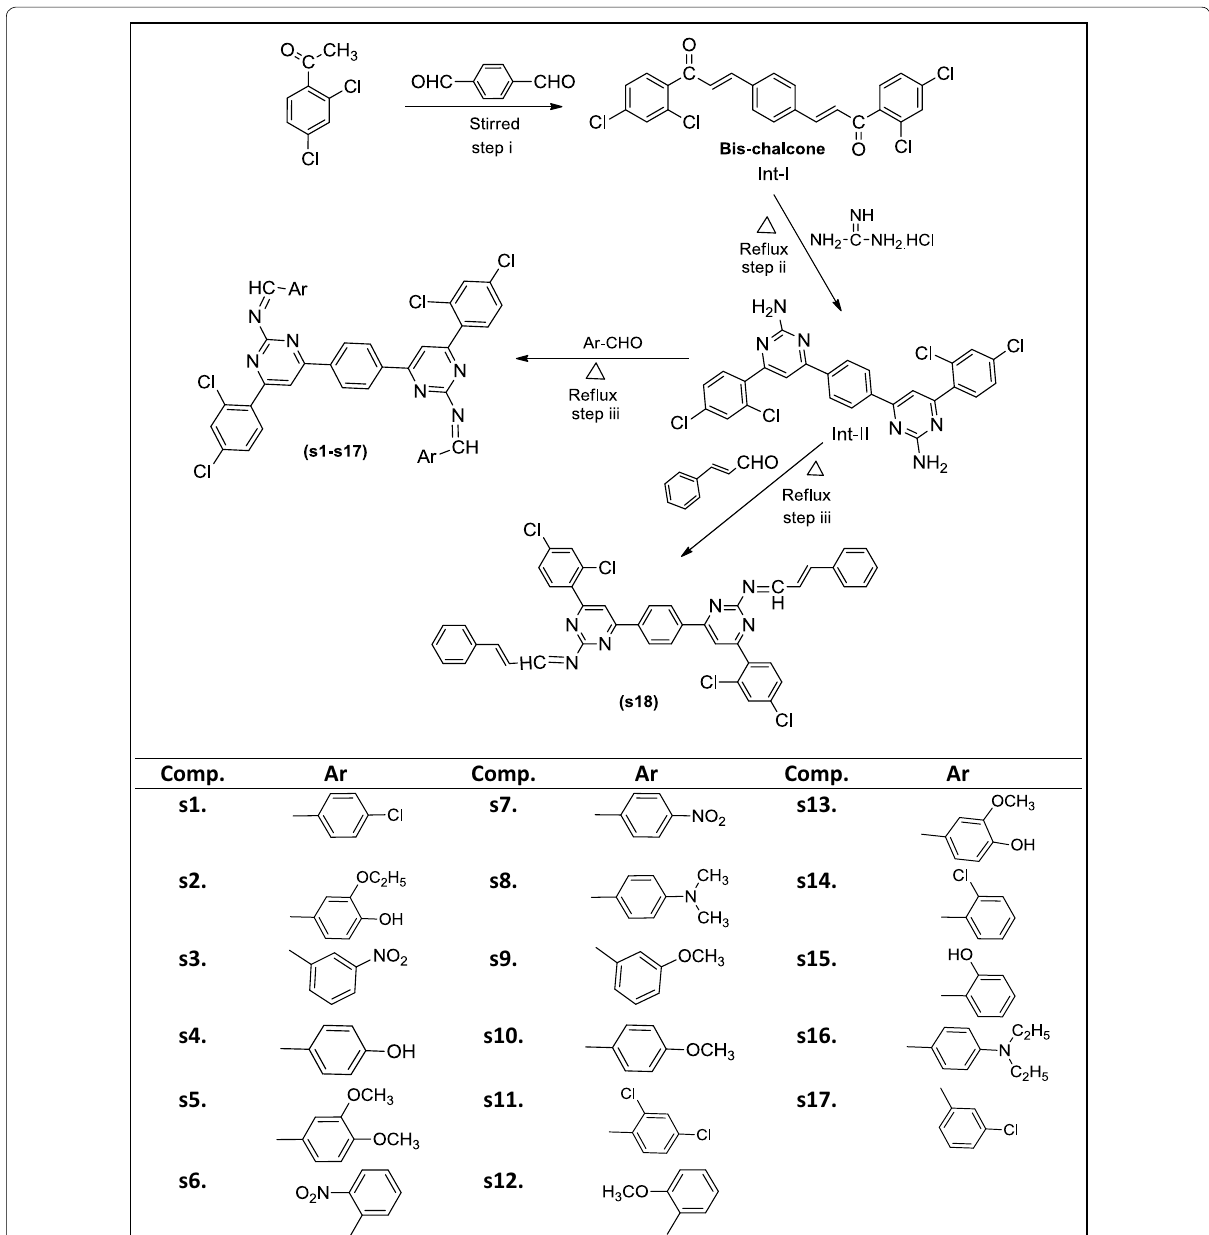
tetramethyl silane (internal standard). 1 H-NMR spectral details of the synthesized derivatives are represented with multiplicity like singlet (s); doublet (d); triplet (t); quar- tet (q); multiplet (m) and the number hydrogen ion. Ele- mental analysis of the synthesized 4,4 ′ -(1,4-phenylene) bis(pyrimidin-2-amine) molecules was obtained by